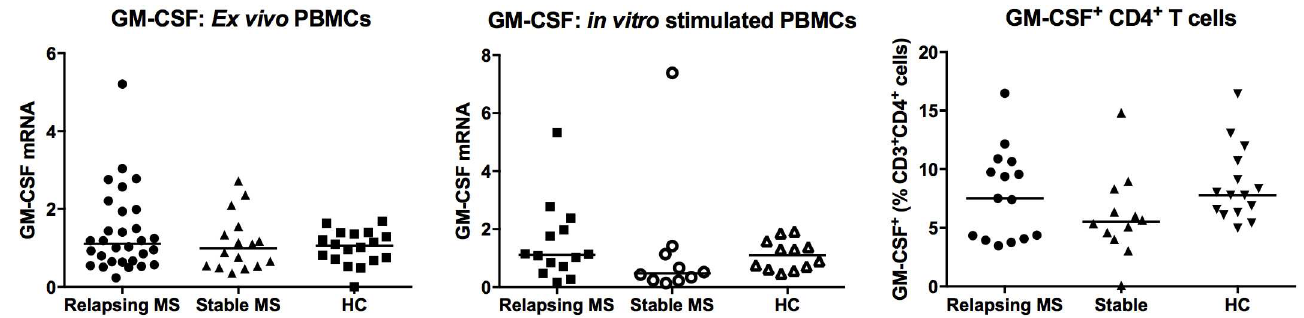
Fig 1. GM-CSF mRNA and GM-CSF-producing cells in PBMCs from relapsing and stable MS patients and from healthy controls (HC). Quantitative-PCR to measureGM-CSF mRNA expression(A) ex vivo (Relapsing MS: n = 30, Stable MS: n = 16, HC: n = 18) and (B) after 4h of stimulationby PMA/ionomycin (RelapsingMS: n = 14, Stable MS: n = 10, HC: n = 12). (C) PBMCs were stainedfor GM-CSF, CD3 and CD4 after 4h stimulationby PMA/ionomycin in the presence of a protein transport inhibitorand analysedby flow cytometry (Relapsing MS: n = 15, Stable MS: n = 12, HC: n = 15). Scatter dot plot illustratesthe percentageof GM-CSF + CD4 + cells. The horizontallines of scatter plots represent the median value in all subgroups.